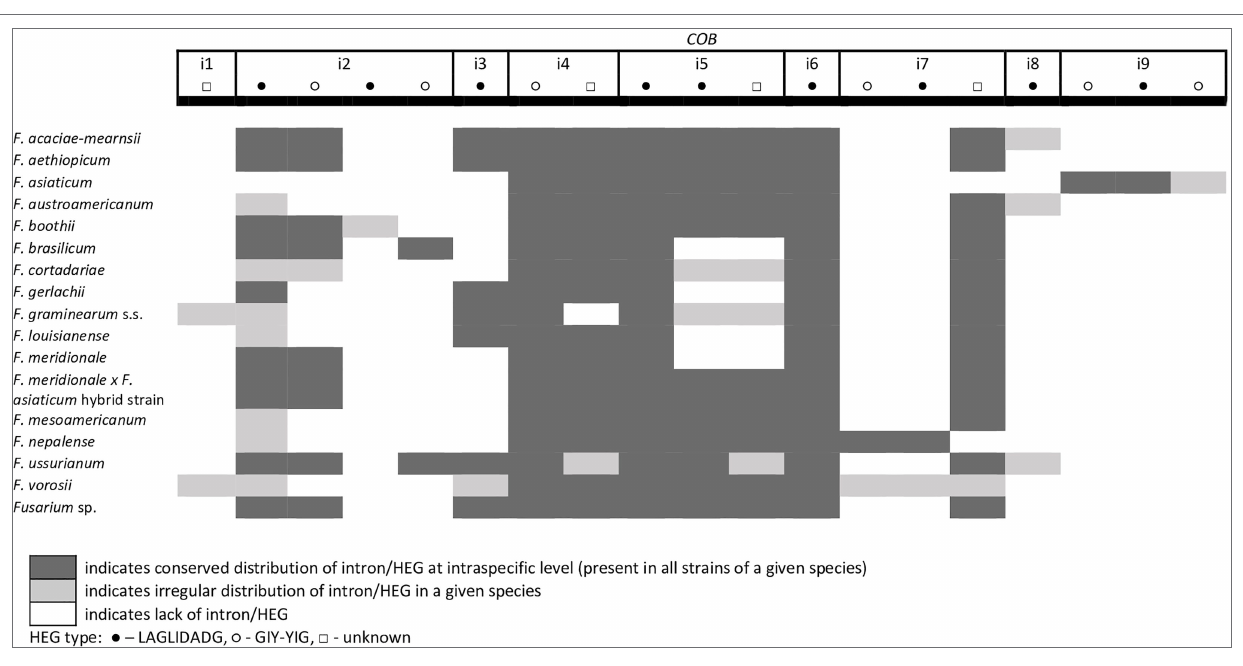
FIGURE 3 | Distribution of introns and associated HEGs found in the COB